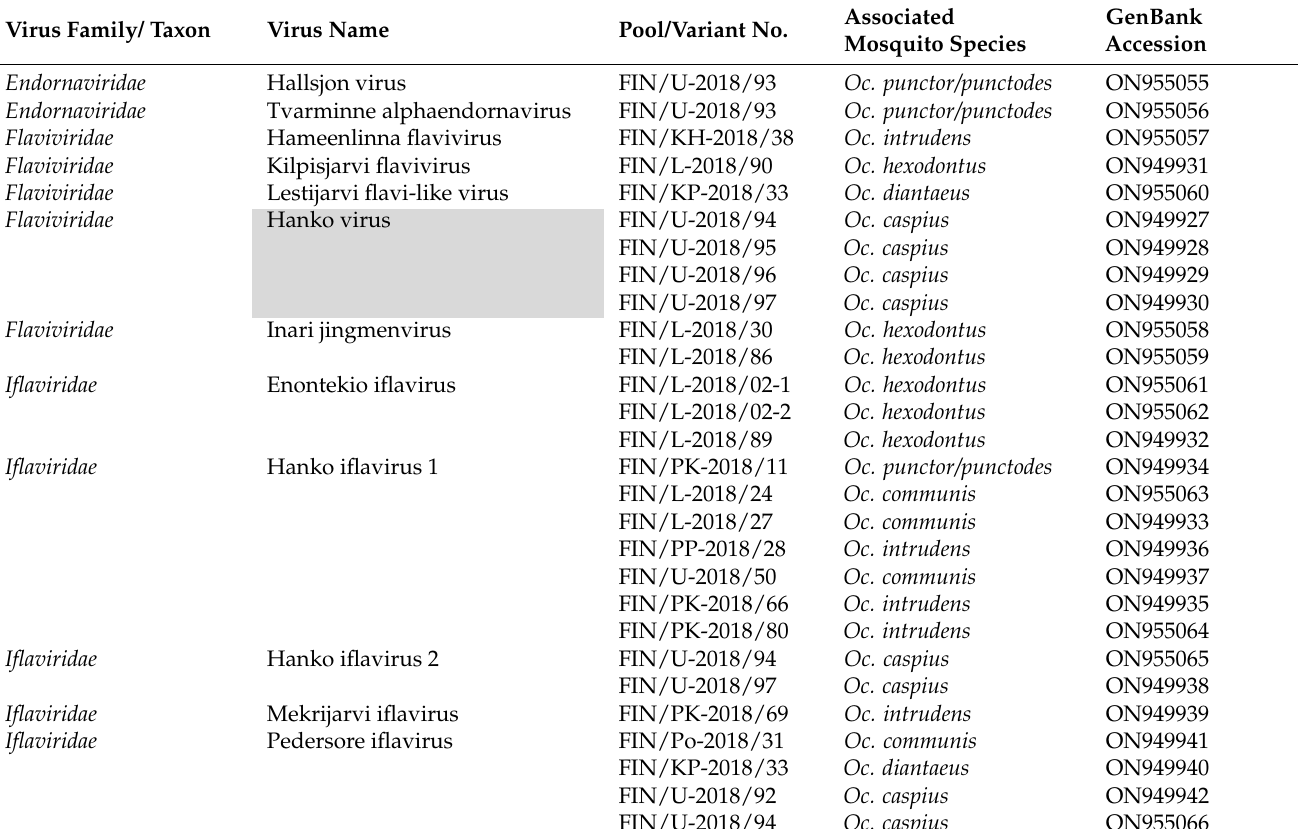
Table 2. +ssRNA viruses sequenced from Finnish mosquitoes. Previously described viruses are shaded grey. Where more than one virus was sequenced from a pool, an additional code was appended to the pool